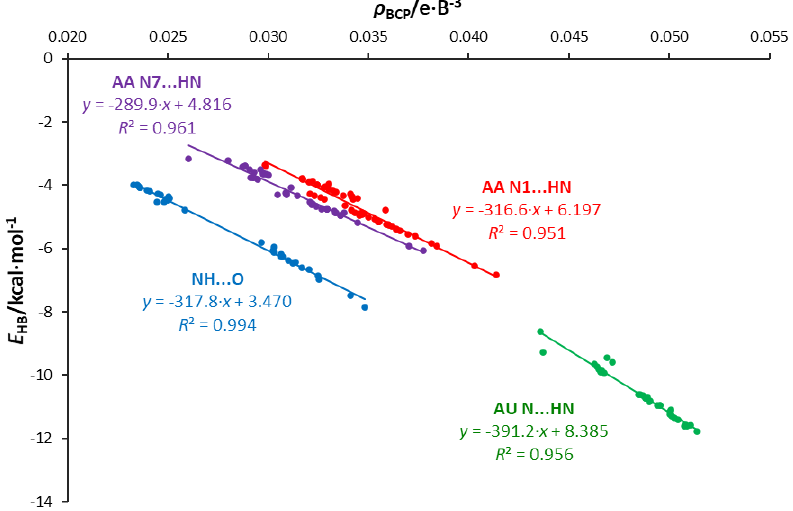
Figure 10. Adenine-adenine dimers. Energy of individual H-bonds as a function of the electron density at the H-bond critical point ρ BCP.